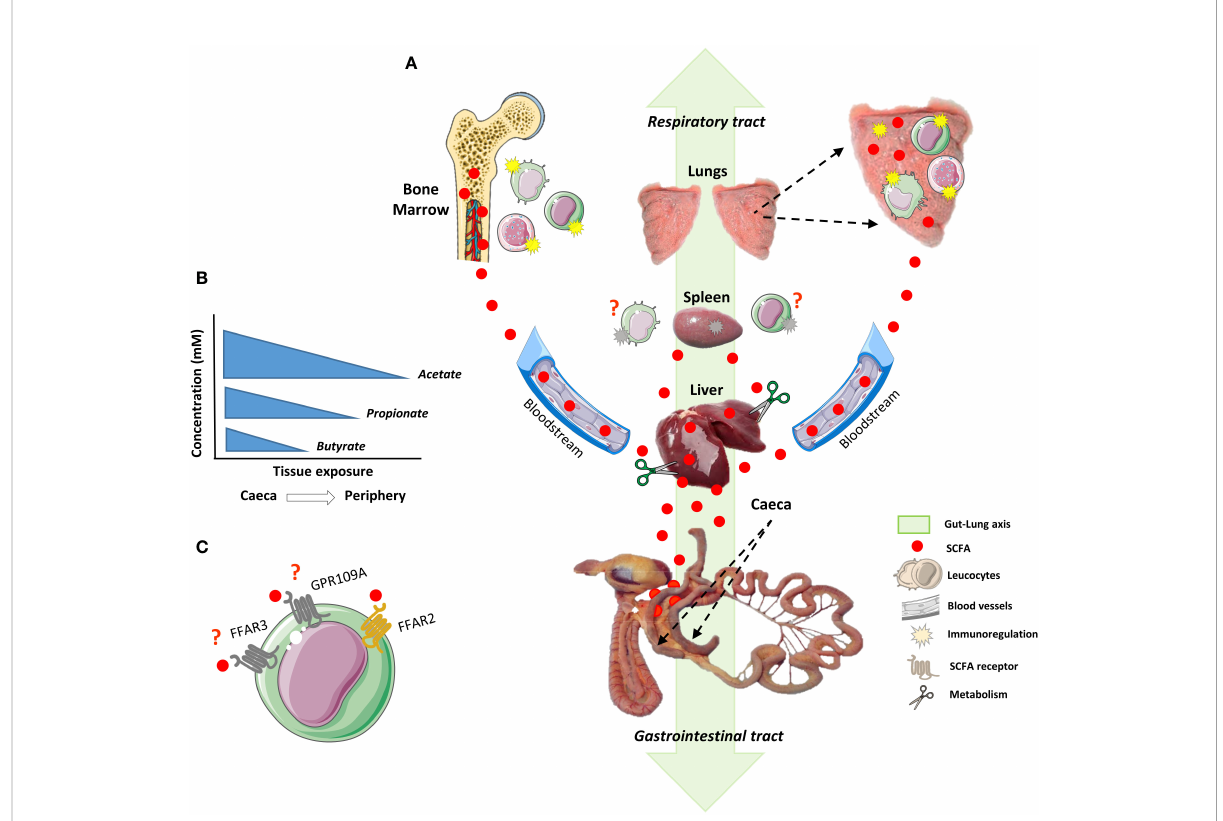
FIGURE 2 The gut-lung axis and how it may operate in the chicken. The development of the immune system goes hand in hand with the acquisition and maintenance of a complex gut microbiota (GM). The GM promotes and calibrates multiple aspects of the immune system maturation and functioning via the release and production of various molecular motifs and metabolites, respectively. These molecules not only modulate local (gut) immunity, but also exercise remote functions on peripheral organs, including the lungs: a phenomenon referred to as the gut – lung axis. In chickens, its existence and functioning remains elusive. (A) Large amounts of short-chain fatty acids (SCFA) are produced in the caeca, a microbiota-enriched portion of the chicken gut where fermentation of dietary polysaccharides takes place. SCFA, the main bioactive end products of fermentation can then act locally (in the gut), or leave the gastrointestinal tract through the bloodstream. When taken up, a large part of the SCFA is used as a source of energy. The part of SCFA that is not consumed by the caecal epithelial cells is transported across the basolateral membrane. To prevent high SCFA concentrations in blood, the liver clears the major part of acetate, propionate and butyrate from the portal circulation. As a general rule it is believed for humans, rodents and livestock species alike, that SCFA concentrations are regulated through a preferential uptake of butyrate by the intestinal epithelium, propionate by the liver and acetate by various peripheral organs (B) . The remainder of SCFA that may reach peripheral organs beyond the liver is mostly unknown. However, part of these SCFA could reach the bone marrow via the bloodstream where they play a role in the development and priming of immune cells. The SCFA reaching the lungs could act in reinforcing the epithelial mucosa or in the priming of resident immune cells, such as phagocytes. However, the role of SCFA in the spleen, the main secondary lymphoid organ, is largely unexplored. (C) SCFA exert their biological functions mainly through G-protein coupled receptors (GPCR), such as FFAR2, FFAR3 and GPR109A. In the chicken, FFAR3 and GPR109A are lacking, and FFAR2 has been shown to possess more than 20 paralogs. To date, the pharmacology of SCFA receptors and their mechanisms of action in the chicken are